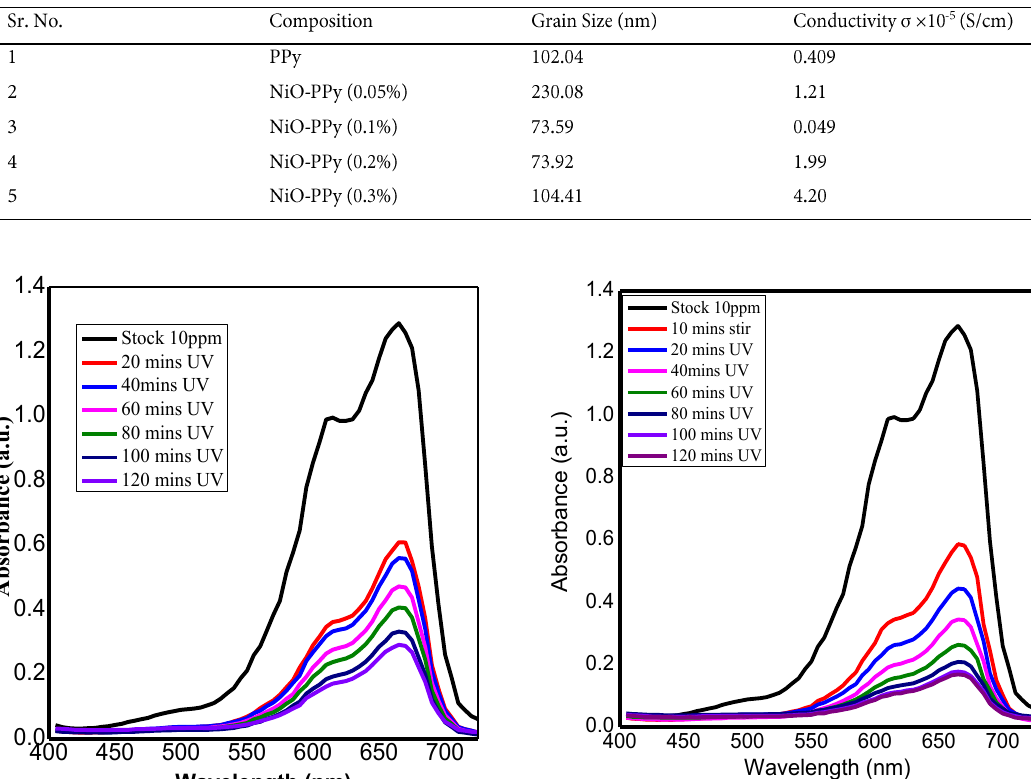
Table 2. Various properties of NiO-PPy hybrid nanocomposites for reaction time 4 hrs.